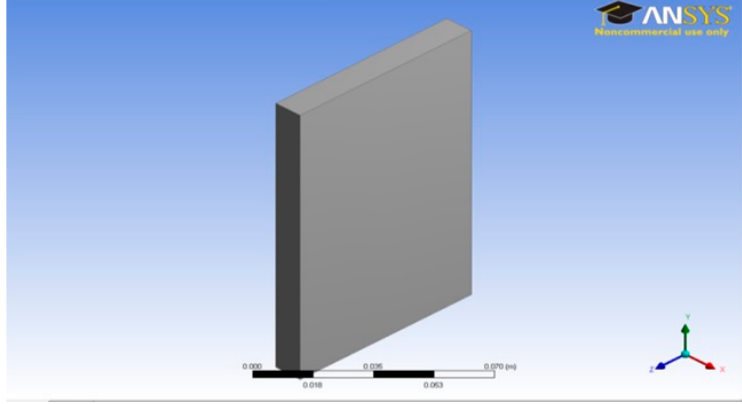
Figure 3. Plain concrete slab model (11 × 7 × 1 cm).